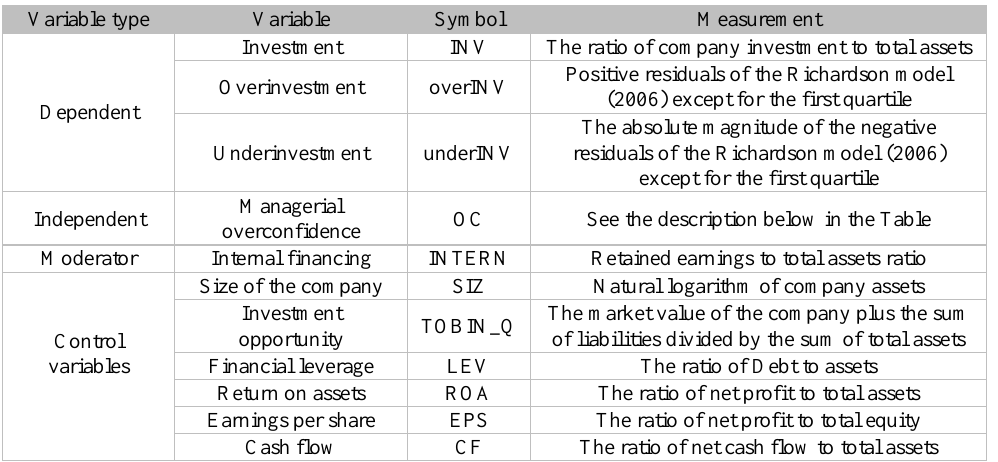
Table 1. Research variables and how they are